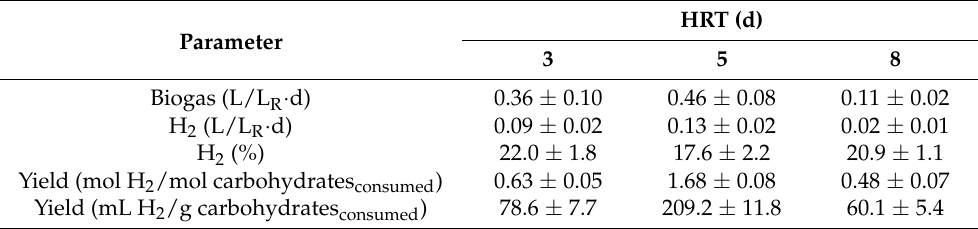
Table 4. CSTR acidogenic reactor performance under steady-state conditions for each